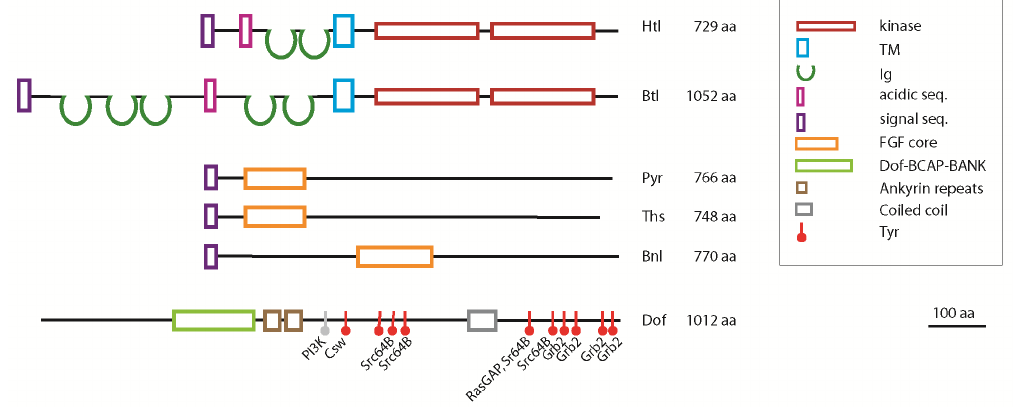
Figure 3. Domain structure of the Drosophila melanogaster FGFRs, FGFs and Dof. Htl is built up of an amino-terminal signal sequence (purple), an acidic region (pink), two Immunoglobulin-like (IG) domains (green loops), a transmembrane domain (light blue) and an intracellular split tyrosine kinase catalytic domain (red). Btl exhibits similar domain composition to Htl, but Btl contains three additional IG-like domains in the extracellular part of the protein. Drosophila FGF ligands possess an amino-terminal signal sequence (purple), the conserved FGF core domain (orange) and a long carboxy-terminal tail. The Dof protein contains a Dof-BCAP-BANK domain (light green) required for receptor binding, two ankyrin repeats (brown) and a coiled-coil domain (grey). Tyrosine residues that are indicated in binding of downstream signalling molecules are marked (red). The Tyrosine residue located within the consensus site for PI3K binding is coloured in light grey